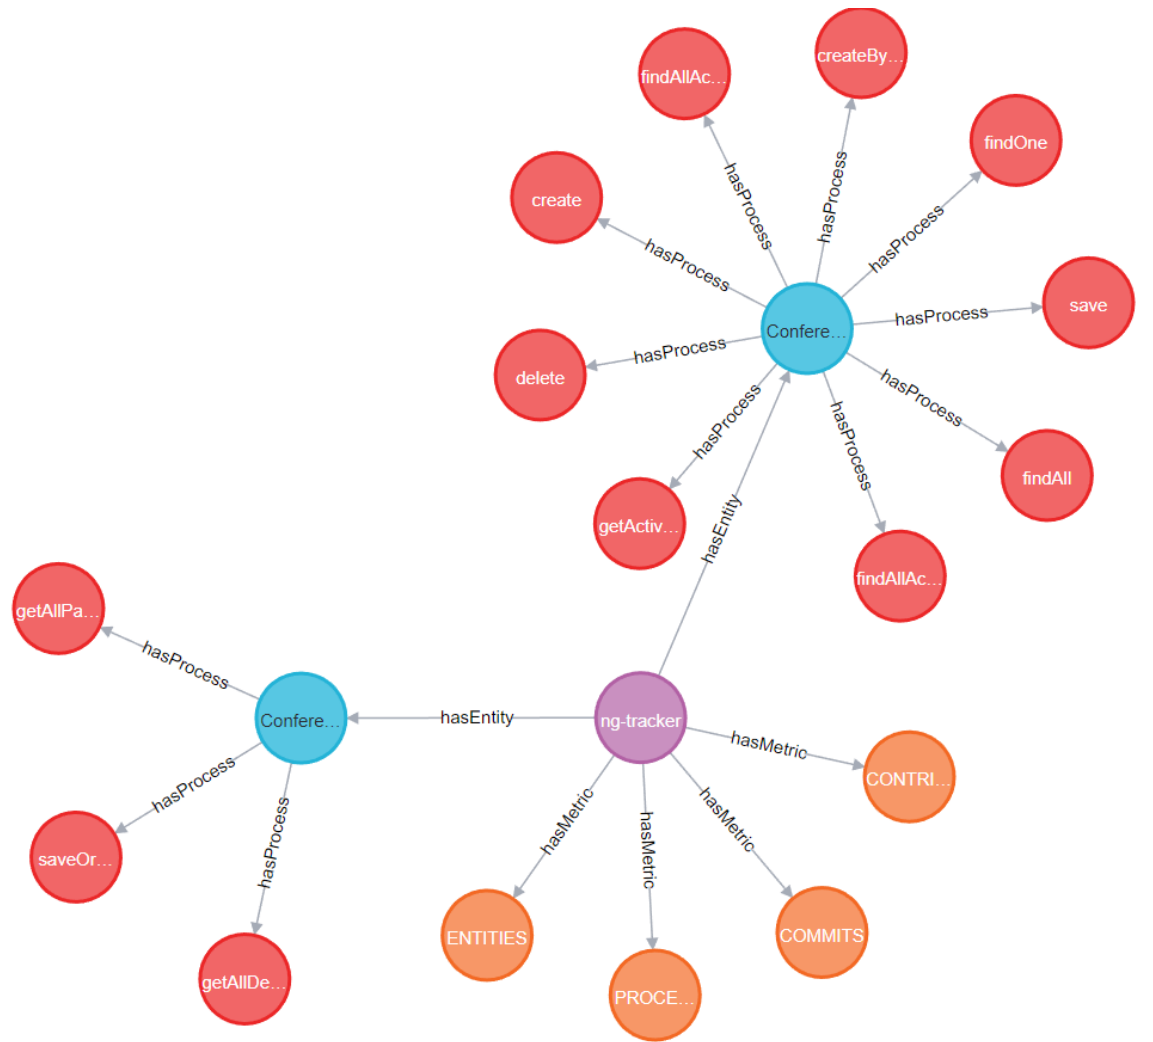
Figure 9. Example of the Neo4j graph for the ng-tracker